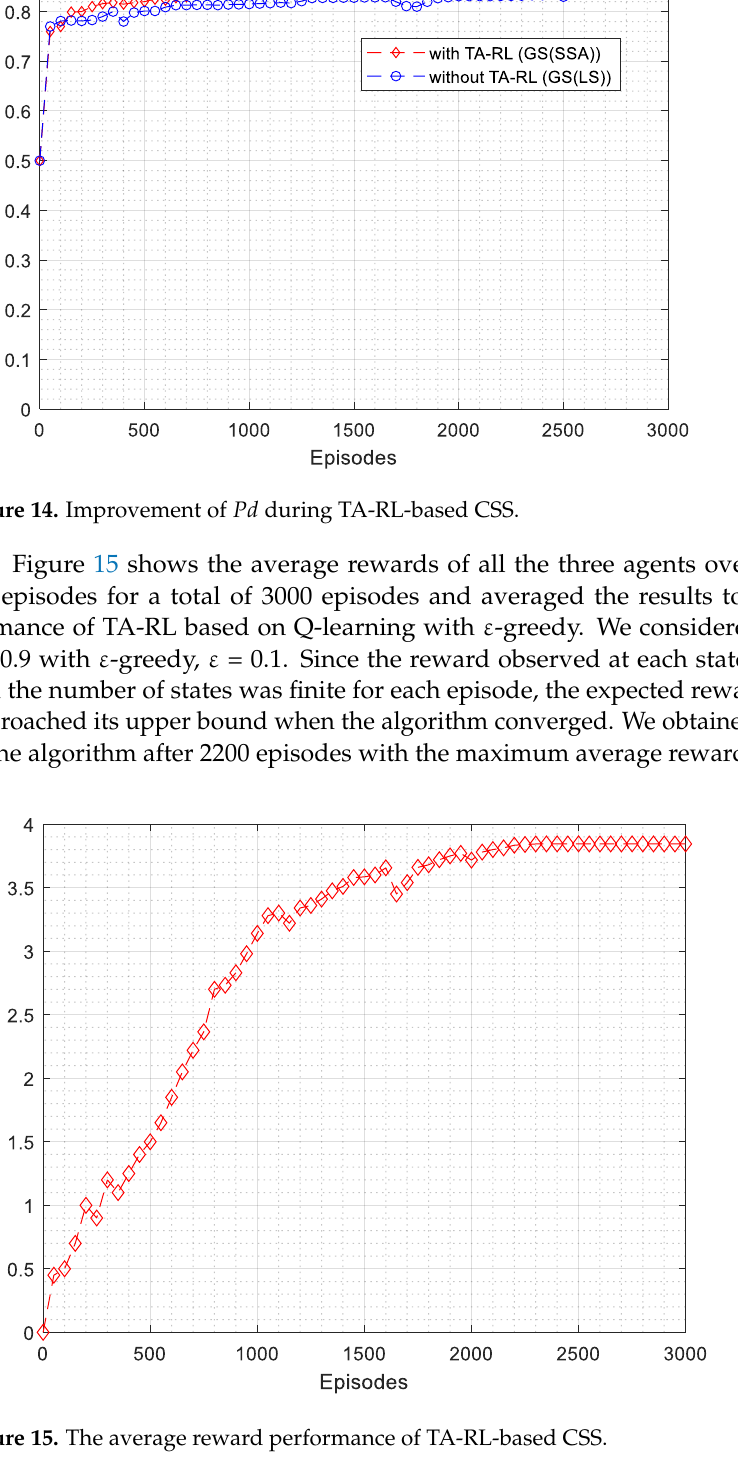
Figure 15. The average reward performance of TA-RL-based CSS.